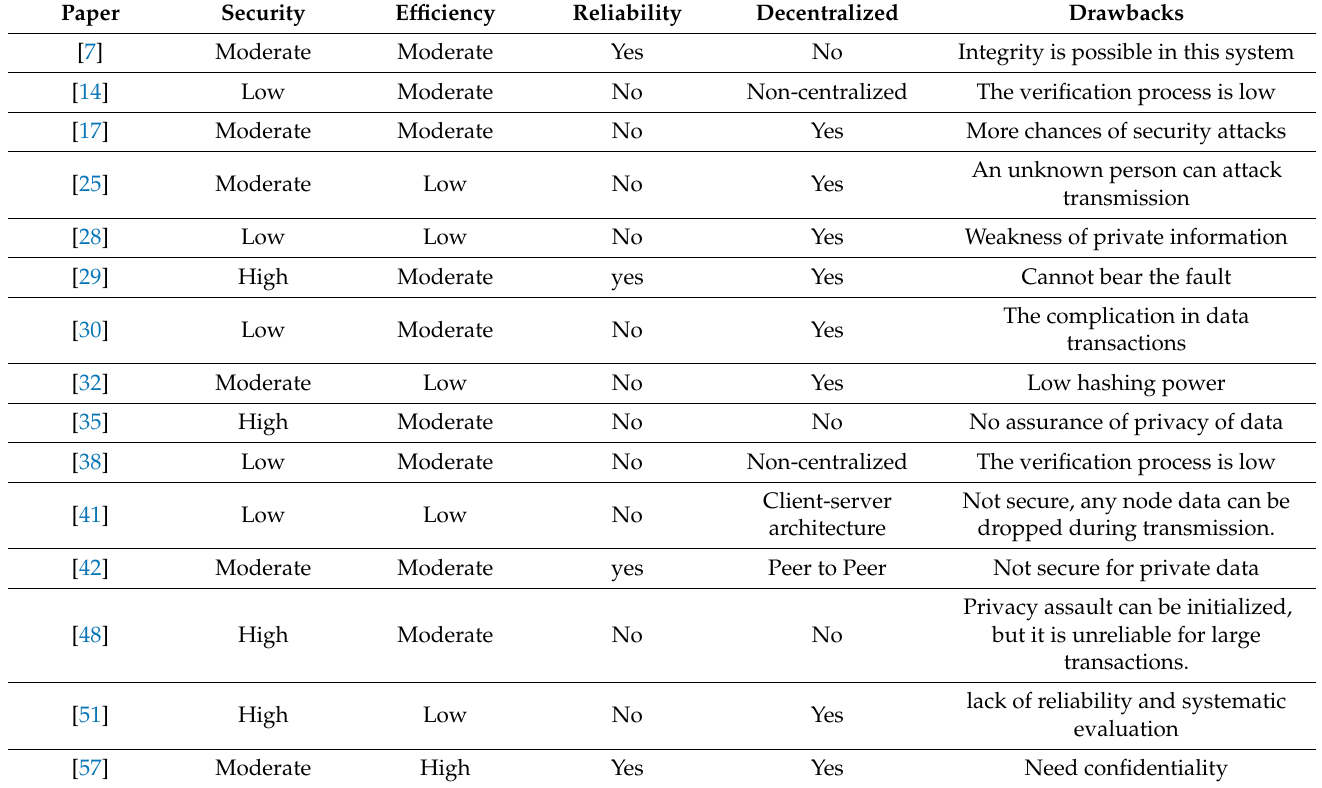
Table 1. Comparison table of previous